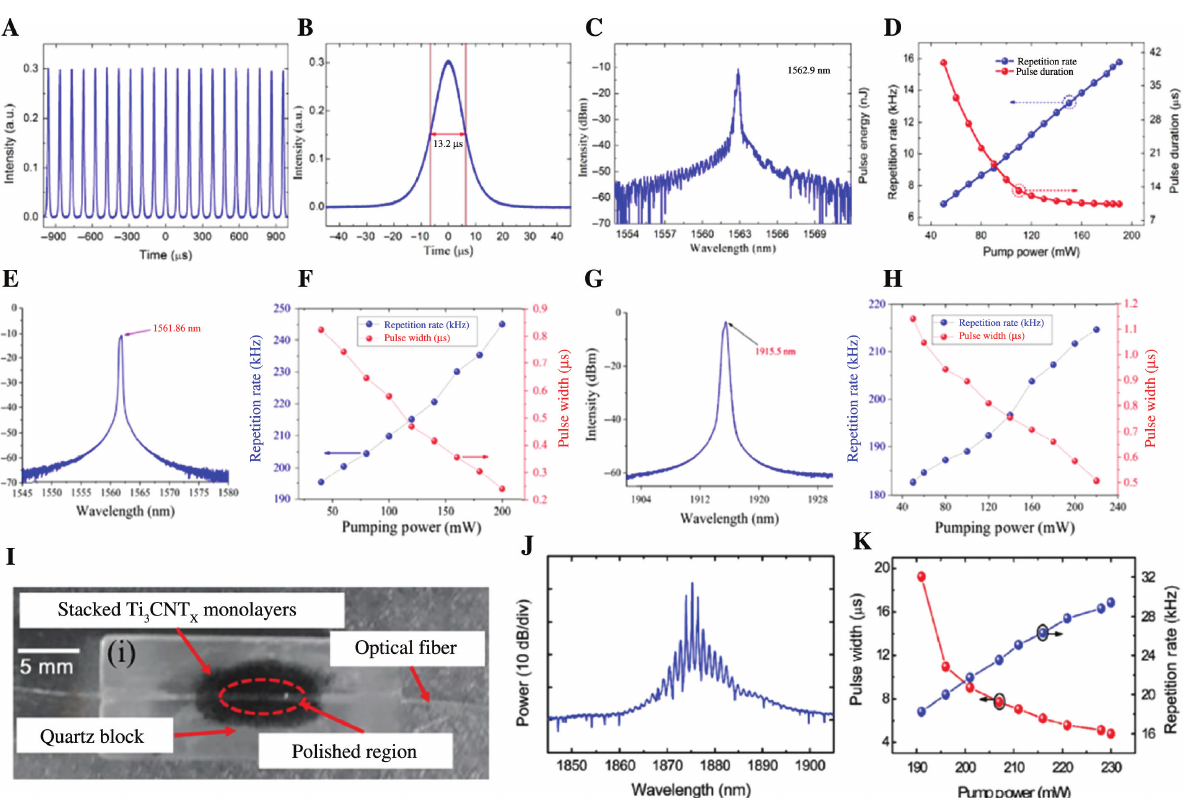
Figure 16: Q-switching fiber lasers with various